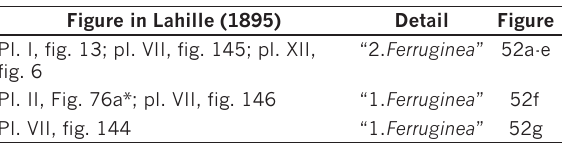
*Figure 146 of Plate VII indicates variety fulgurea , whereas legend on figure 76a of plate II corresponds to V. paradoxa . Figure 67a only in- dicates V. tuberculata , so it probably corresponds to this shell. On the MLP label, it is assigned to this variety with